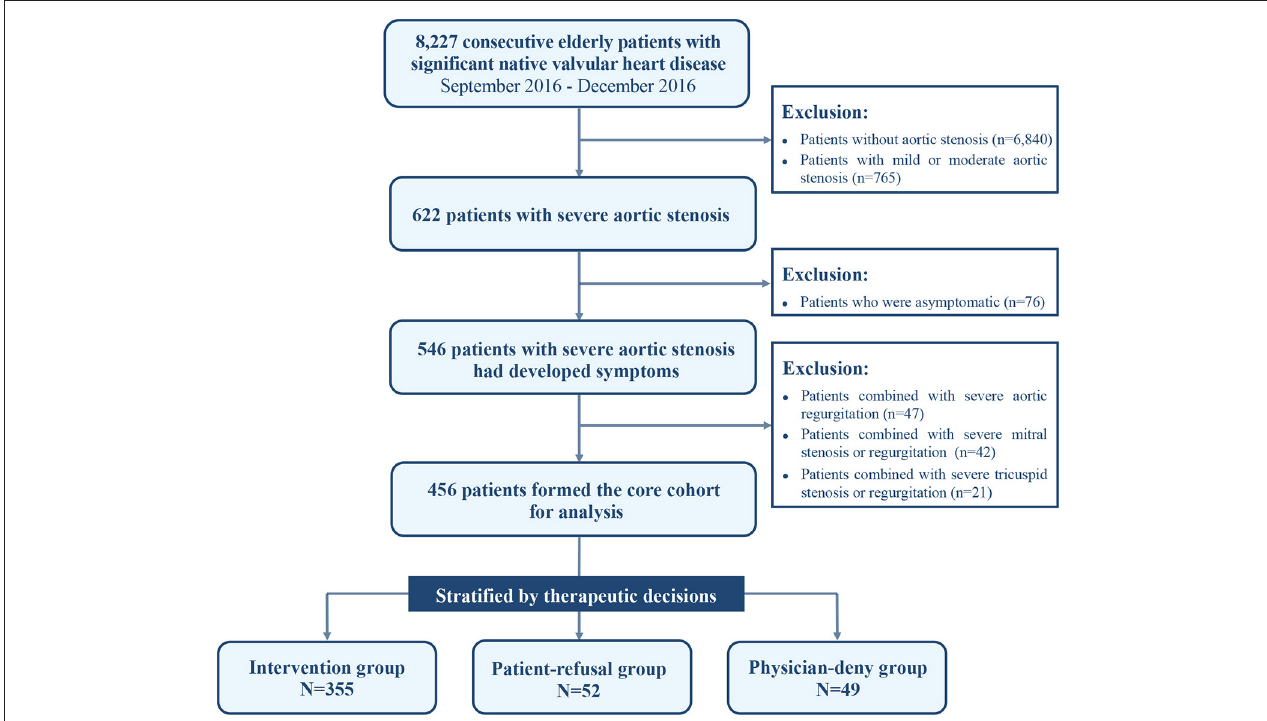
FIGURE 1 | Study cohort flow diagram.